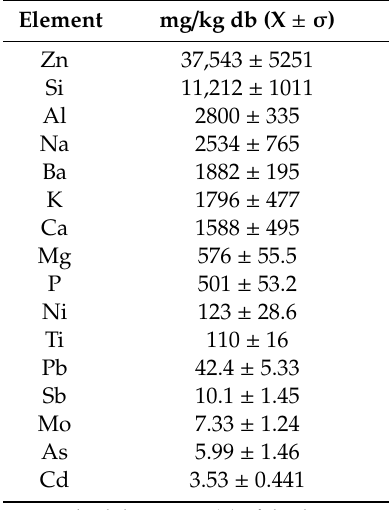
Table 2. Mineral content (mg / kg db) of ST